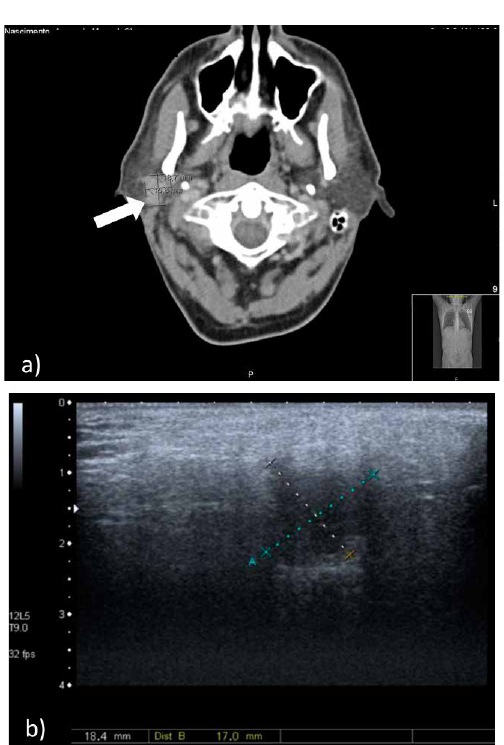
Figure 1: Cervico-thoraco-abdominal CT scan exposed a 16 × 1 × 17 mm nodular image on the right parotid gland (a); Parotid ultrasound documented a non specific 18 mm hypoechogenic nodule in the right parotid gland, with no signs of vascular invasion and no cervical adenomegalies